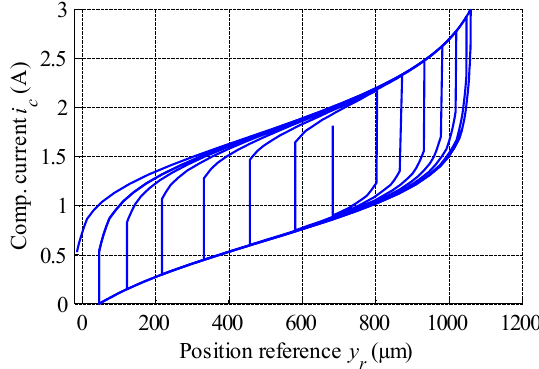
Figure 15. IGPI model output showing the relationship between position reference and compensation current.